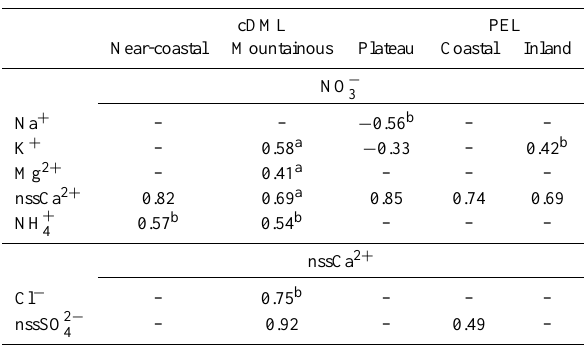
Table 1. Correlation coefficients of NO − major ions at 99% significance.